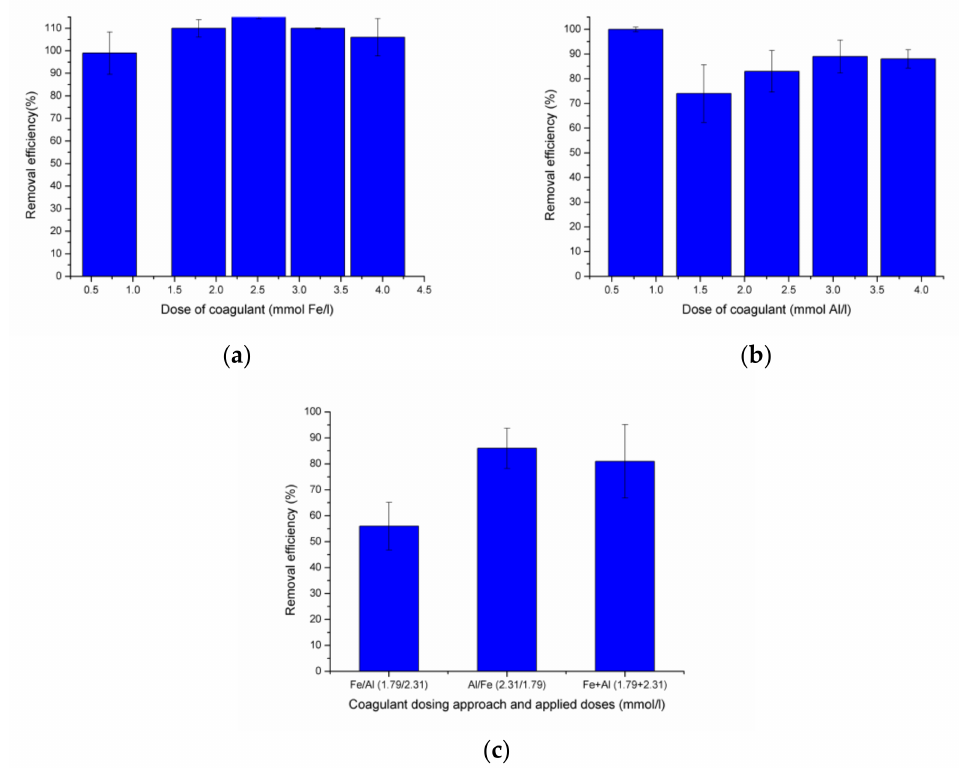
Figure 9. Efficiency of the removal of textile fibers from a surface water by coagulation with ( a ) FeCl 3 , ( b ) PACl, and ( c ) a combination of FeCl 3 and PACl (error bars show standard deviation of